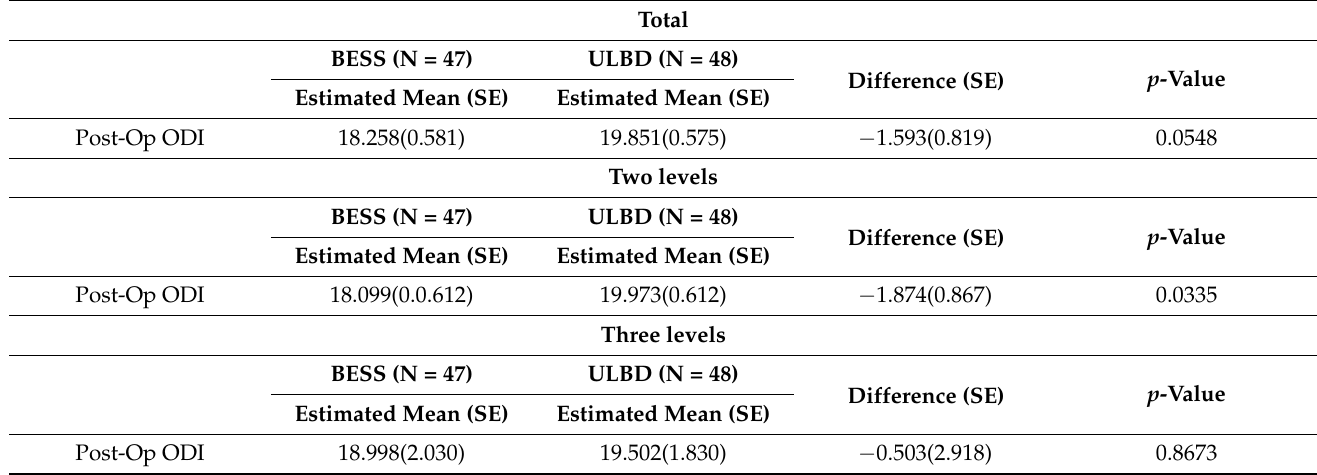
Table 5. Clinical outcomes: ODI change by range of levels.